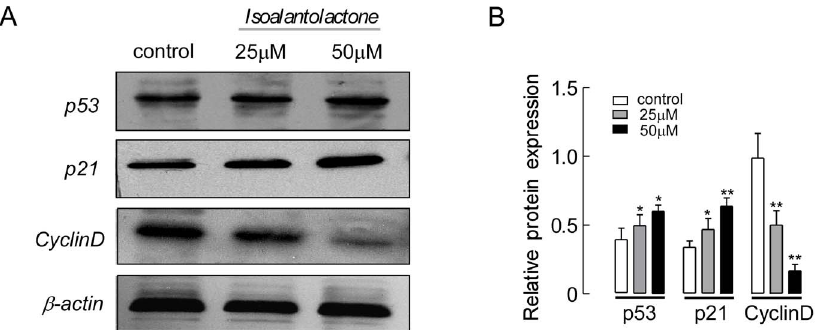
Figure 4. The effect of isoalantolactone on the expression of cell cycle regulators in UM-SCC-10A cells. (A) Representative pictures for p53, p21 and cyclin D protein expression by western blot analysis. b -actin was used as a control. (B) Isoalantolactone up-regulated p53 and p21 expression, while down-regulating cyclin D expression in a dose-dependent manner. The results are represented as the means 6 SEM from three independent experiments with similar results. * P , 0.05 and ** P , 0.01 compared to the control.